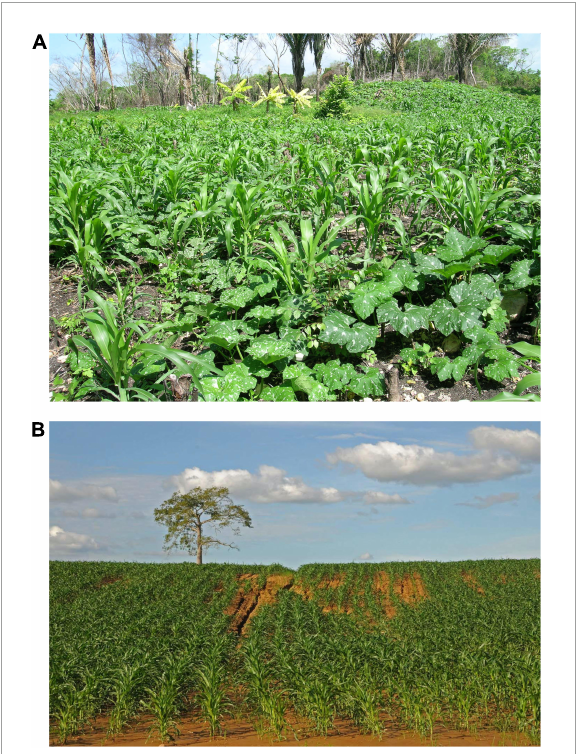
FIGURE2 Comparison of fields (A) complex milpa field with little erosion, (B) plowed maize field with significant erosion. Credit ISBER/MesoAmerican Research Center,